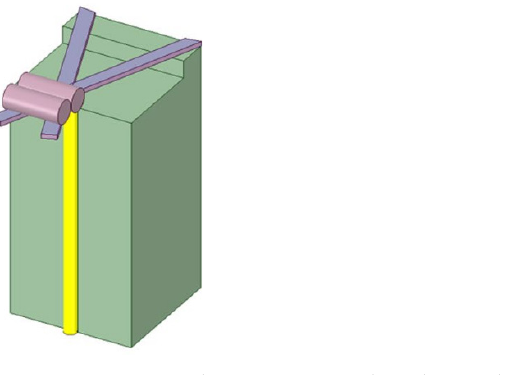
Figure 9. Seismic accelerometer sensor based on X ‐ shaped cantilever [75].